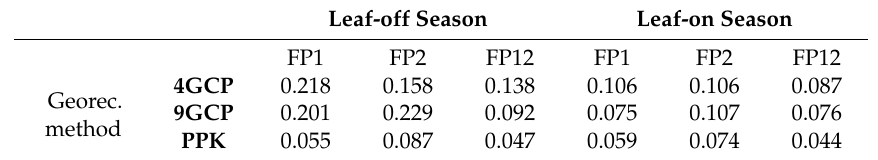
Table 7. Horizontal root mean square errors (RMSE xy ) for point positions in the orthomosaic (in meters).